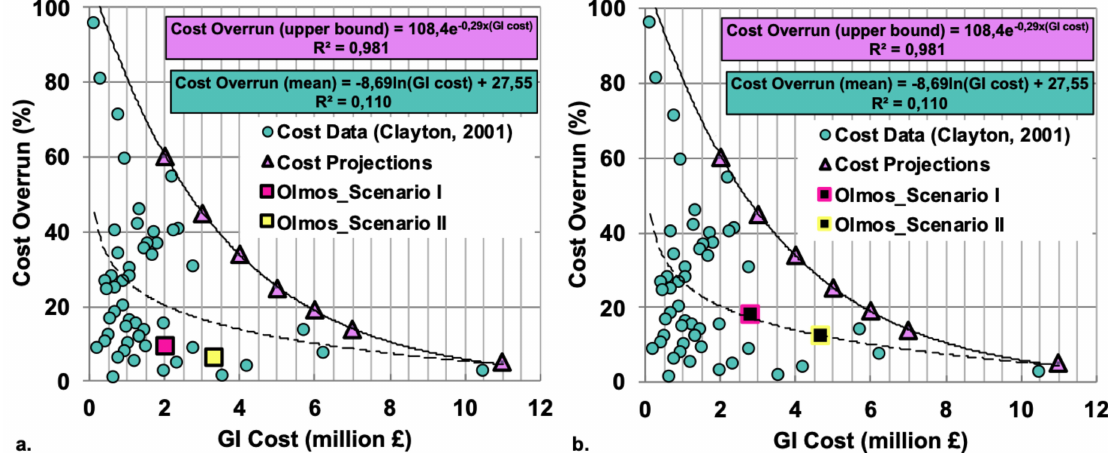
Figure 20. Tunnelling Cost Overrun Projection for Olmos Tunnel: ( a ) no inflation and ( b ) with